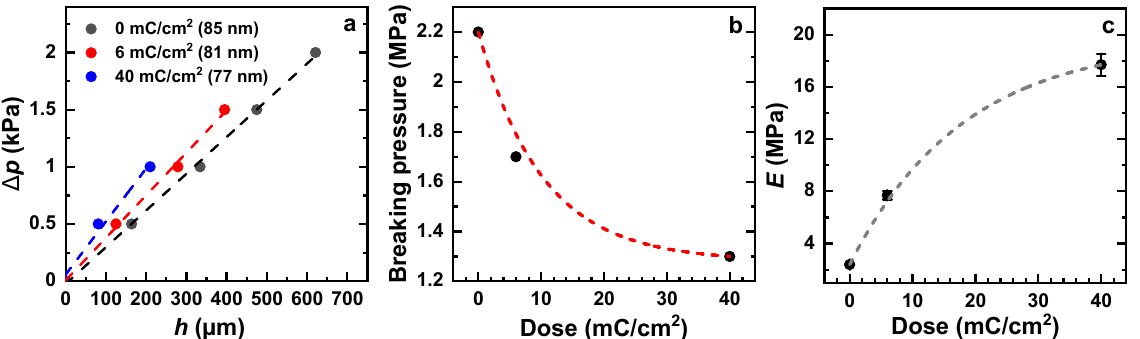
Figure 8. ( a ) ∆ p vs. h plots for the pristine and irradiated (electrons) PEG membranes (see the legend for the thickness value); a nearly linear dependence is tentatively traced by the straight lines. ( b ) The pressure corresponding to the breaking of these membranes as a function of irradiation dose. ( c ) Young’s modulus of these membranes as a function of irradiation dose. The window diameter was 1 mm.